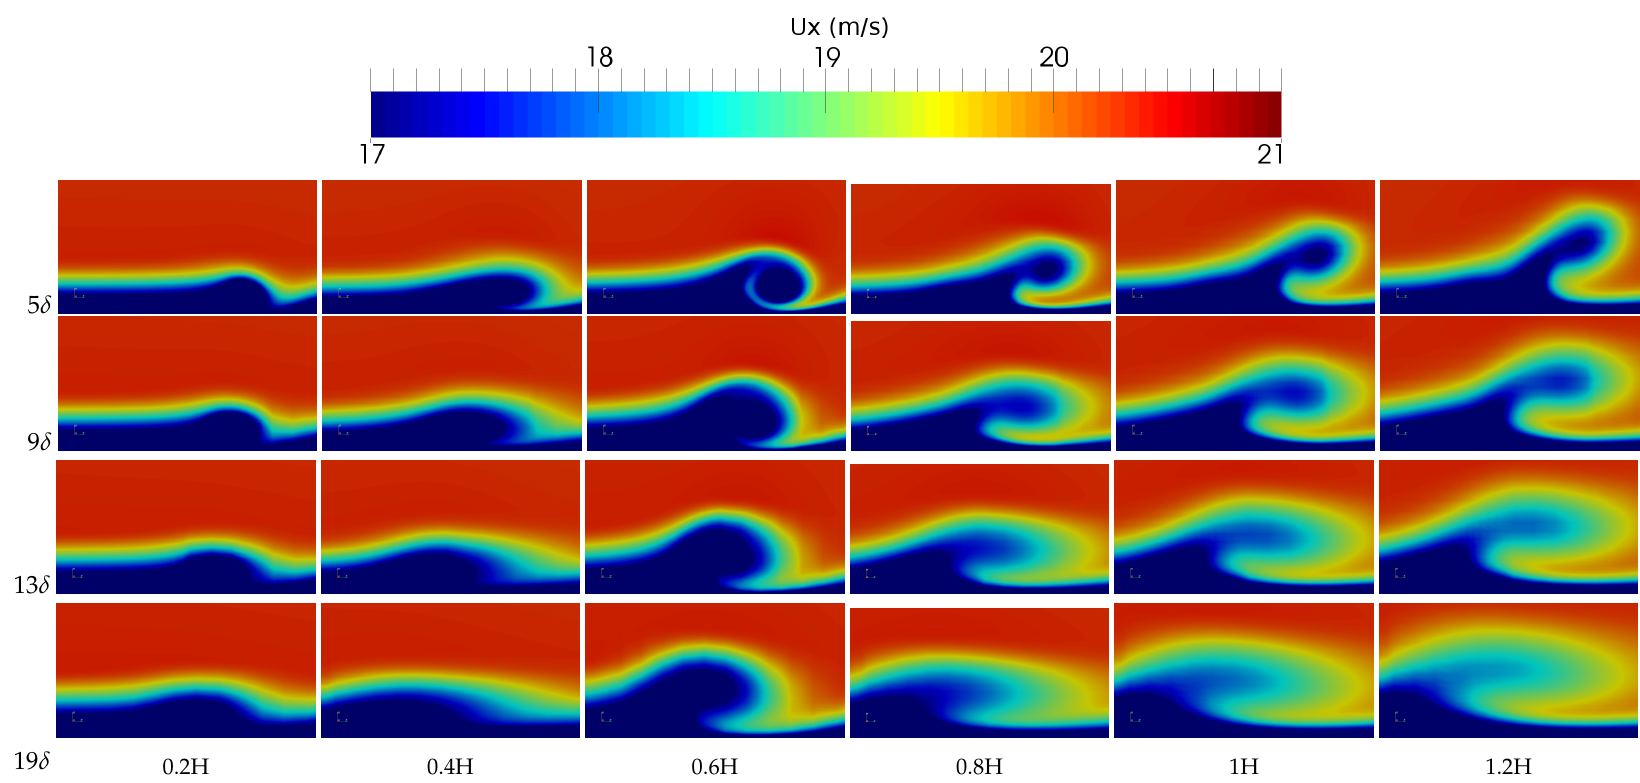
Figure A3. Axial velocity distributions Ux ms − 1 at four different planes normal to the streamwise direction and located at distances proportional to the local boundary layer thickness δ from the edge shown for six vortex generator heights (0.2H, 0.4H, 0.6H, 0.8H, H and 1.2H). Incident angle of β = 18 ◦